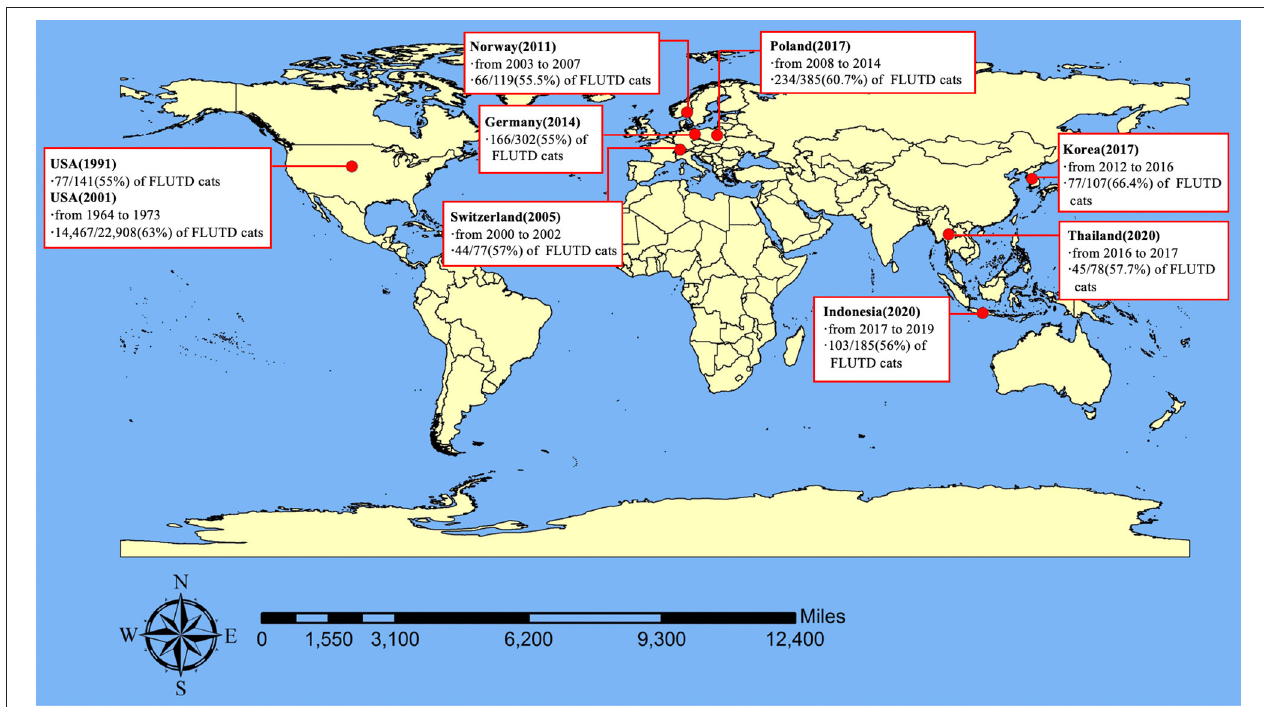
FIGURE 1 | Prevalence of